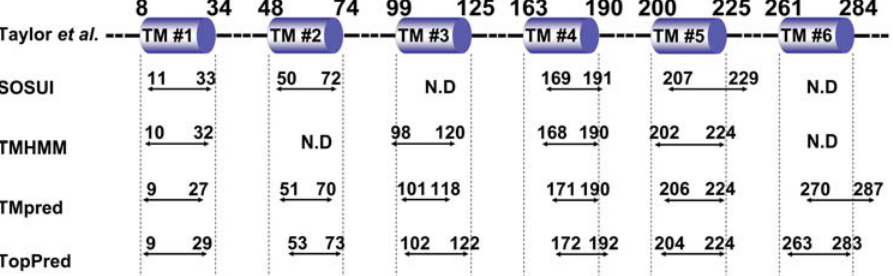
Figure 1. Alignment of predicted hydrophobic domains of gp91 phox . This schema summarizes the different prediction of topology for gp91 phox by using different programs (Sosui, TMHMM, TMpred and TopPred) or the model published by Taylor et al